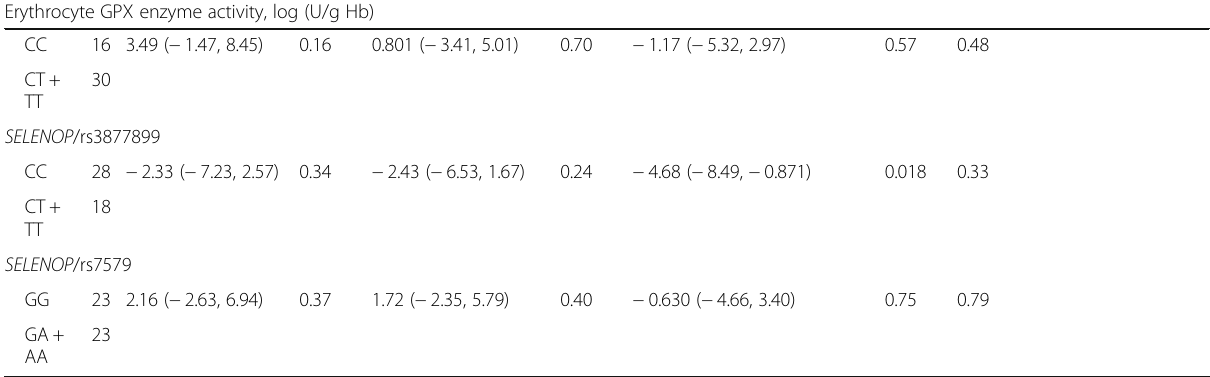
Table 3 Association between mean concentrations of erythrocyte GPX enzyme activity, whole blood selenium, and selenoprotein P in relation to the studied polymorphisms, and within-subject effects between genotype and time in the intervention group (Continued) Erythrocyte GPX enzyme activity, log (U/g Hb)